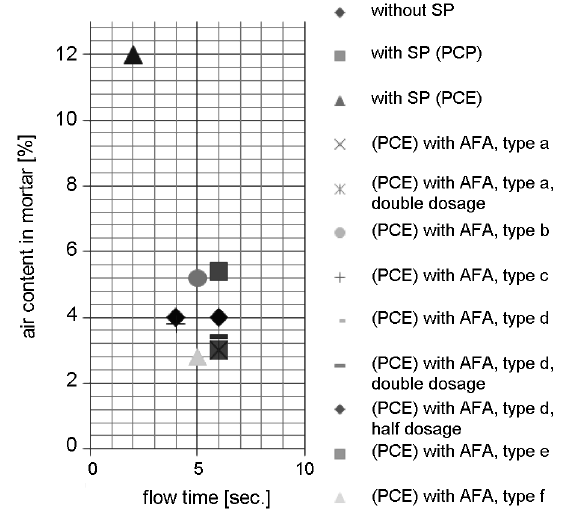
Fig. 3. The influence of the type of AFA and SP on the relation- ship between flow time and air content in mortar